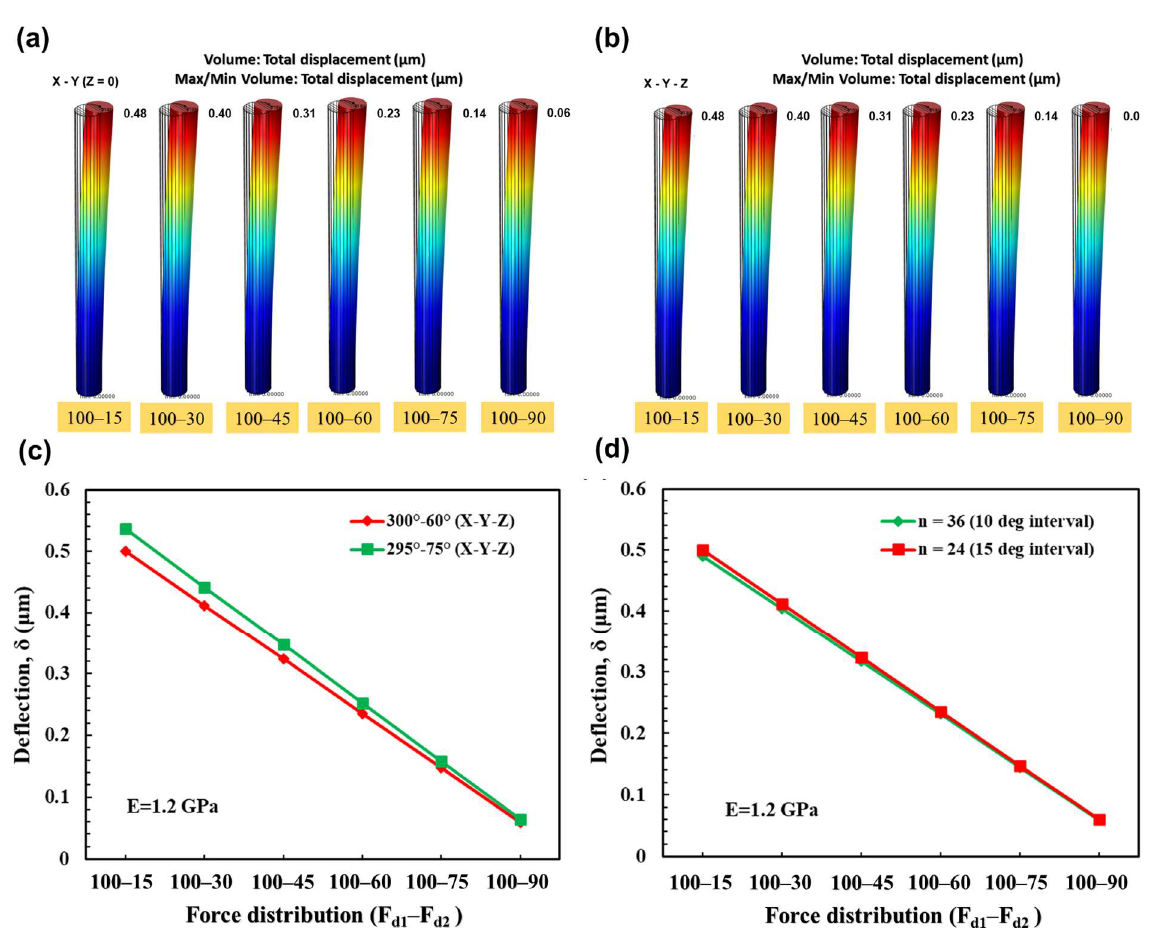
Figure 3. ( a ) 2D (X-Y only) and ( b ) 3D (X-Y-Z) are COMSOL simulation results. The micropillars height is h = 9 µ m and their diameter is d = 0.75 µ m. The top right of each micropillar displays the amount of its deflection in µ m which are rounded to the hundredths place. ( c ) Shows negligible effect of effective capillary force zone. The green line shows the deflection of the micropillar for effective zone of the capillary force extended from 285° to 75°, which is close to that of 300° to 60° (red one). ( d ) Shows the increase of the micropillar deflection with an increase in asymmetric force distribution as well as negligible effect of the Z component of the capillary force on the micropillar deflection.